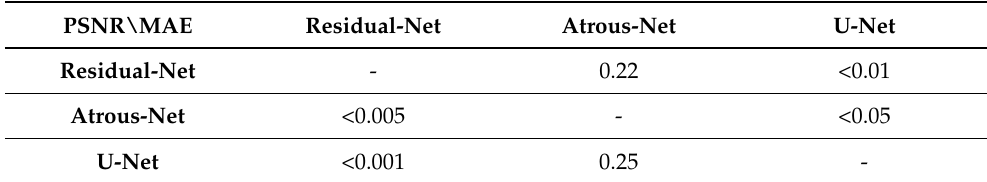
Table 28. MAE and PSNR p -values for 2D Pelvis. p -values of paired Student’s t -test for MAE and PSNR results with 2D architectures with the pelvis dataset.